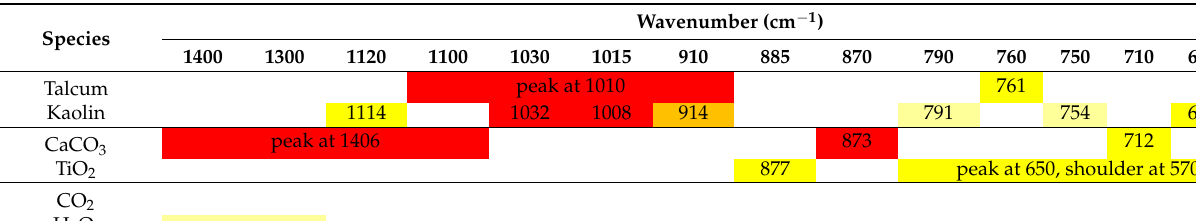
Table 1. Specific signals of some mineral fillers and atmospheric species. Relative intensity correlates to the color, red (strong), orange (medium), yellow (weak), and light yellow (very weak). Adapted with permission from ref. [19].